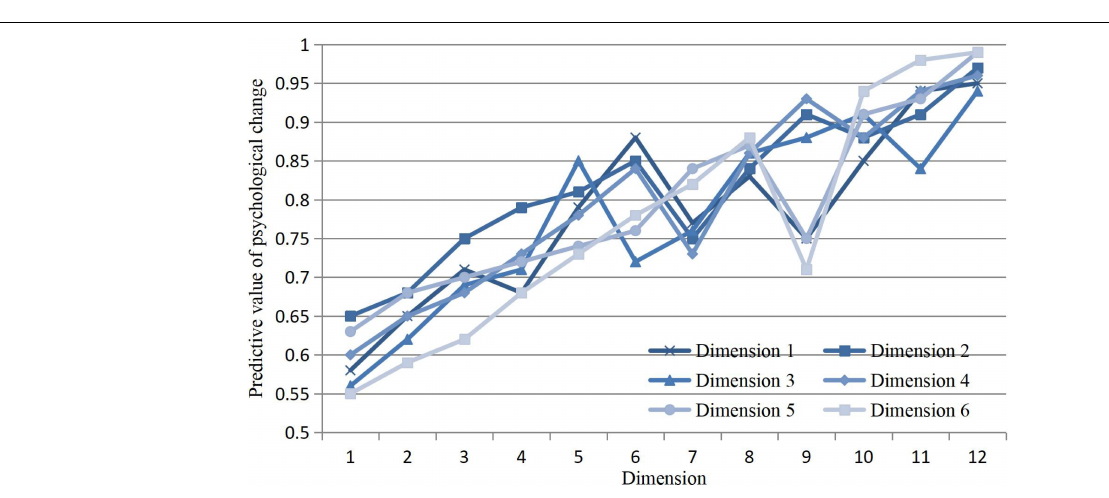
FIGURE 4 | Prediction results of psychological intervention under different